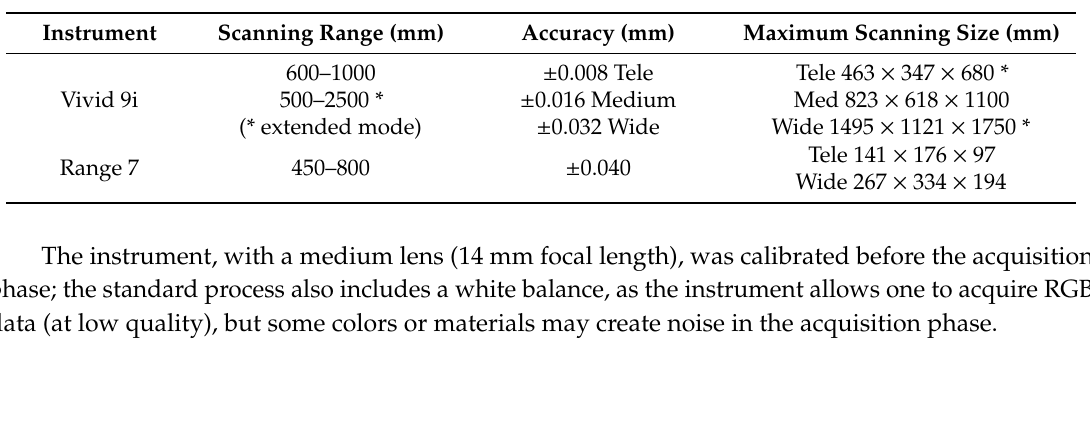
Table 1. Technical characteristics of the two triangulation-based laser